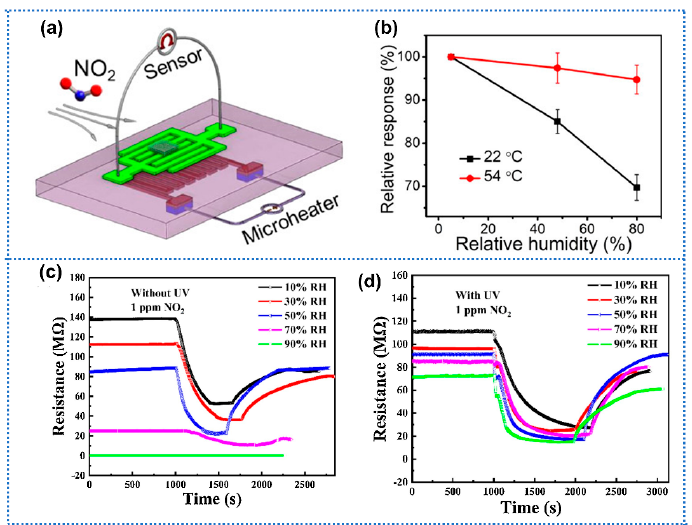
Figure 9. ( a ) Schematic illustration of the synthesis of 3D SnO 2 /RGOH sensor with a microheater. Figure 9. ( a ) +5]Schematic illustration of the synthesis of 3D SnO 2 /RGOH sensor with a ( b ) Plot of relative responses of SnO 2 /RGOH to 3 ppm NO 2 vs. RH at 22 and 54 °C, respectively.